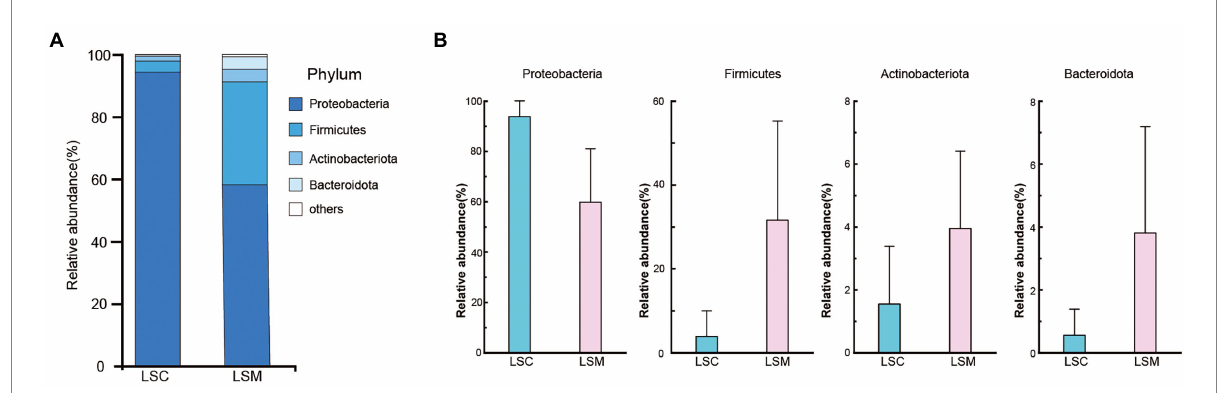
FIGURE 6 Composition of the phylum of the gut microbiota in S. grahami . (A) Relative abundance of the first five phyla. (B) Comparative differences at the phylum level of the gut microbiota. * p < 0.05.